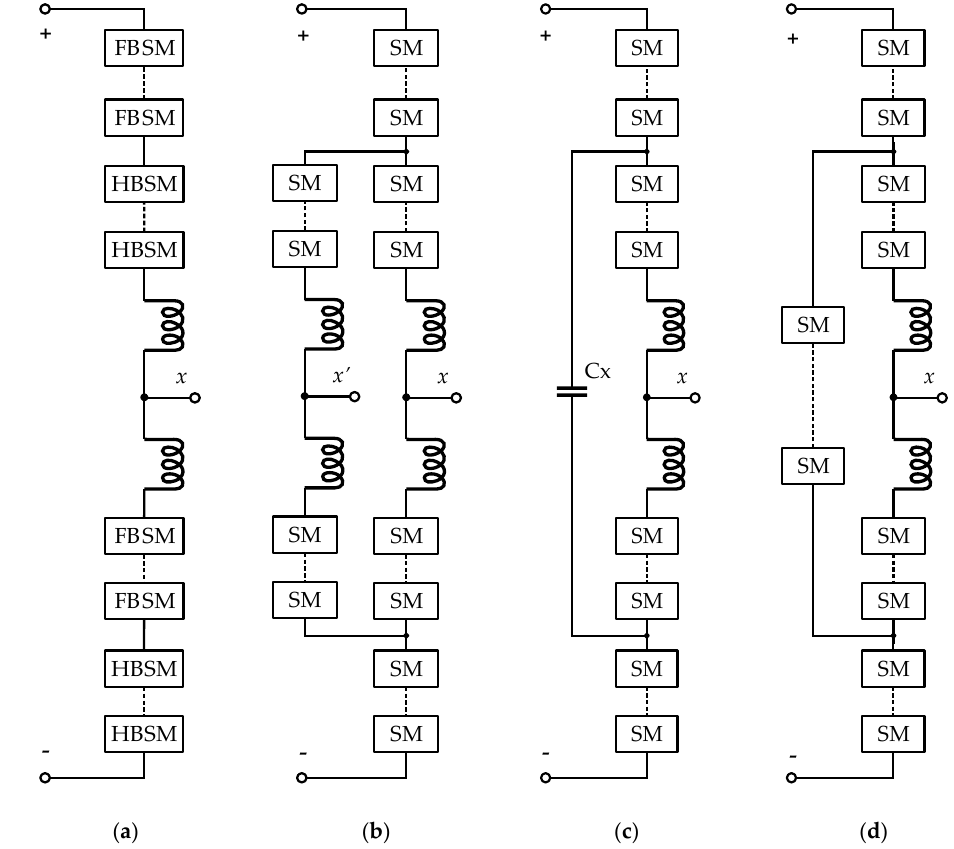
Figure 4. Overall single-phase configurations topologies: ( a ) Symmetric hybrid MMC; ( b ) Bifurcate MMC; ( c ) PC-MMC; (d) AC-MMC.